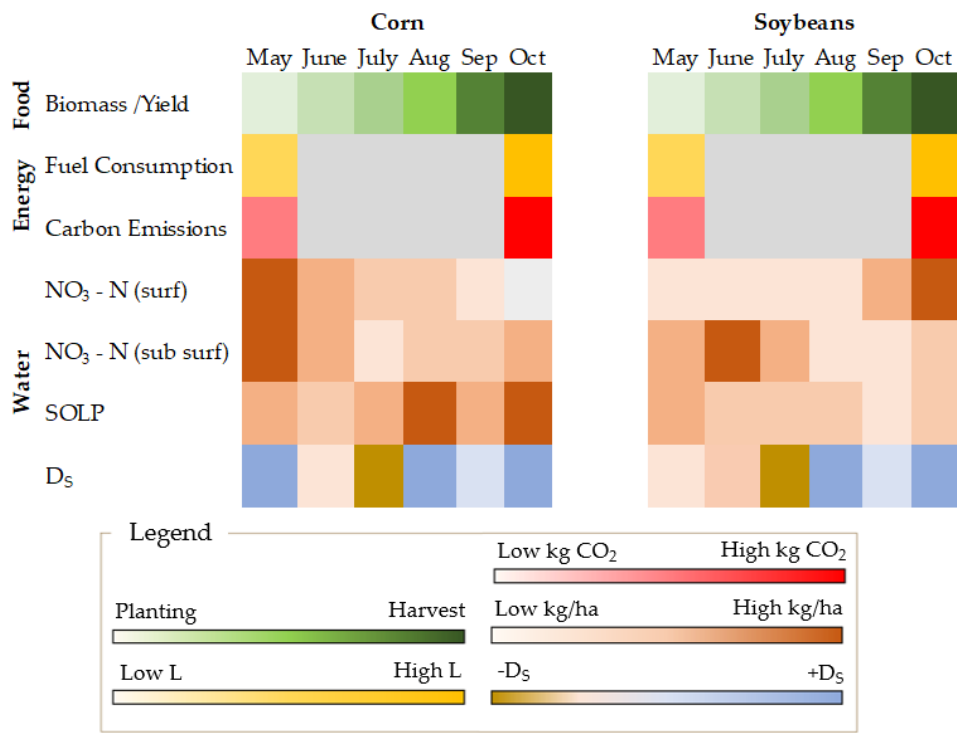
Figure 7. Summary of monthly (May–October) patterns for corn and soybeans in the Matson Ditch Watershed across the various aspects of the FEW nexus during the 2006–2012 time period. The color-scales indicate low values with lighter colors and higher values with darker colors. For food: the crops continue to grow until at the end of the growing season, in this case, in October. For energy: fuel usage and carbon emissions for each year can be determined for the agronomic calendars for each crop, along with their associated carbon emissions. For water: water quality loads for various pollutants (surface nitrate, NO 3 -N (surf); subsurface nitrate, NO 3 -N (sub surf); and soluble phosphorus, SOLP) are mapped out across the growing season for each crop. For water quantity, deficits and surpluses (D S ) are indicated for each month for each crop.